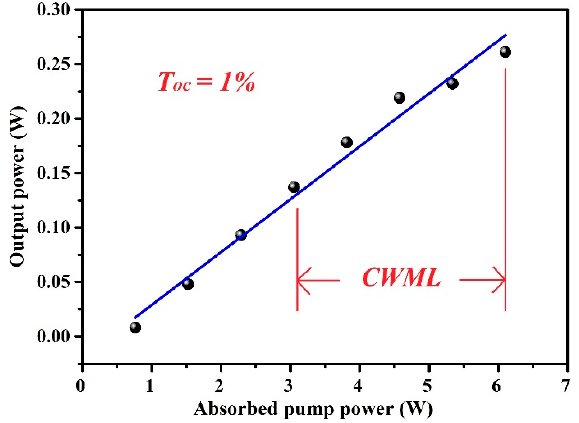
Figure 5. The CW mode-locking output power versus the absorbed pump power.